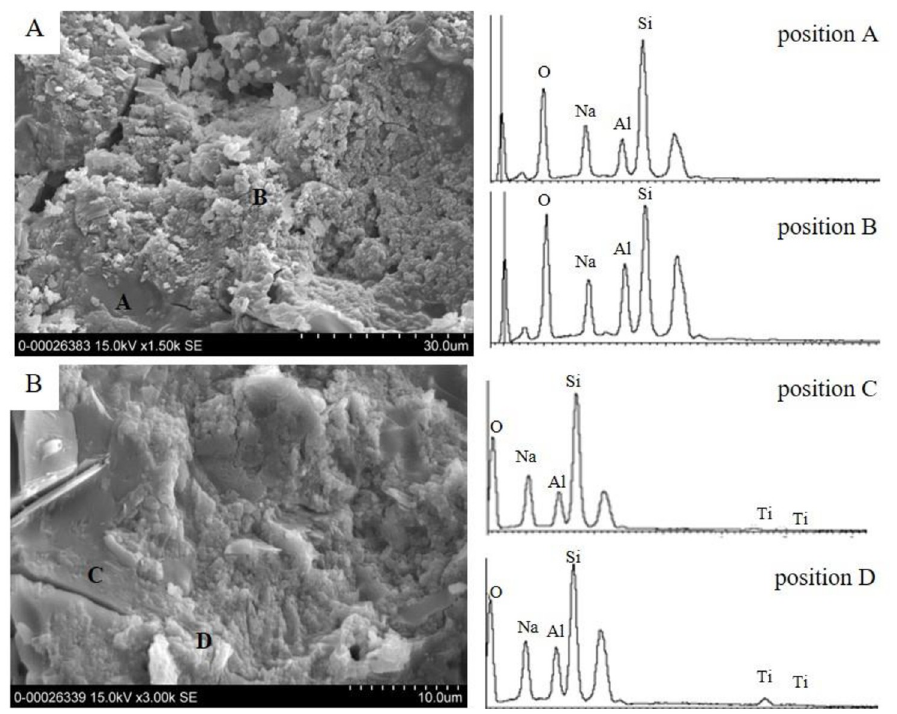
Fig 7. FE-SEM photomicrographs and EDS spectra of MK-based geopolymer synthesized with 40 wt% of (A) zeolite and (B) TiO 2 /zeolite. https://doi.org/10.1371/journal.pone.0241603.g007 These bands are associated with the weak bonds in H or trapped in the cavities of the geopolymers. The absorption band at around 1450 cm -1 corre- sponded to the vibrations caused by the presence of Na cm -1 was assigned to the internal asymmetric stretching vibration of Si-O-T (T = Si or Al) in the aluminosilicate geopolymeric matrix formed because of the polycondensation or poly- merization reaction [43–46]. The adsorption band at 564 cm -1 was attributed to the external